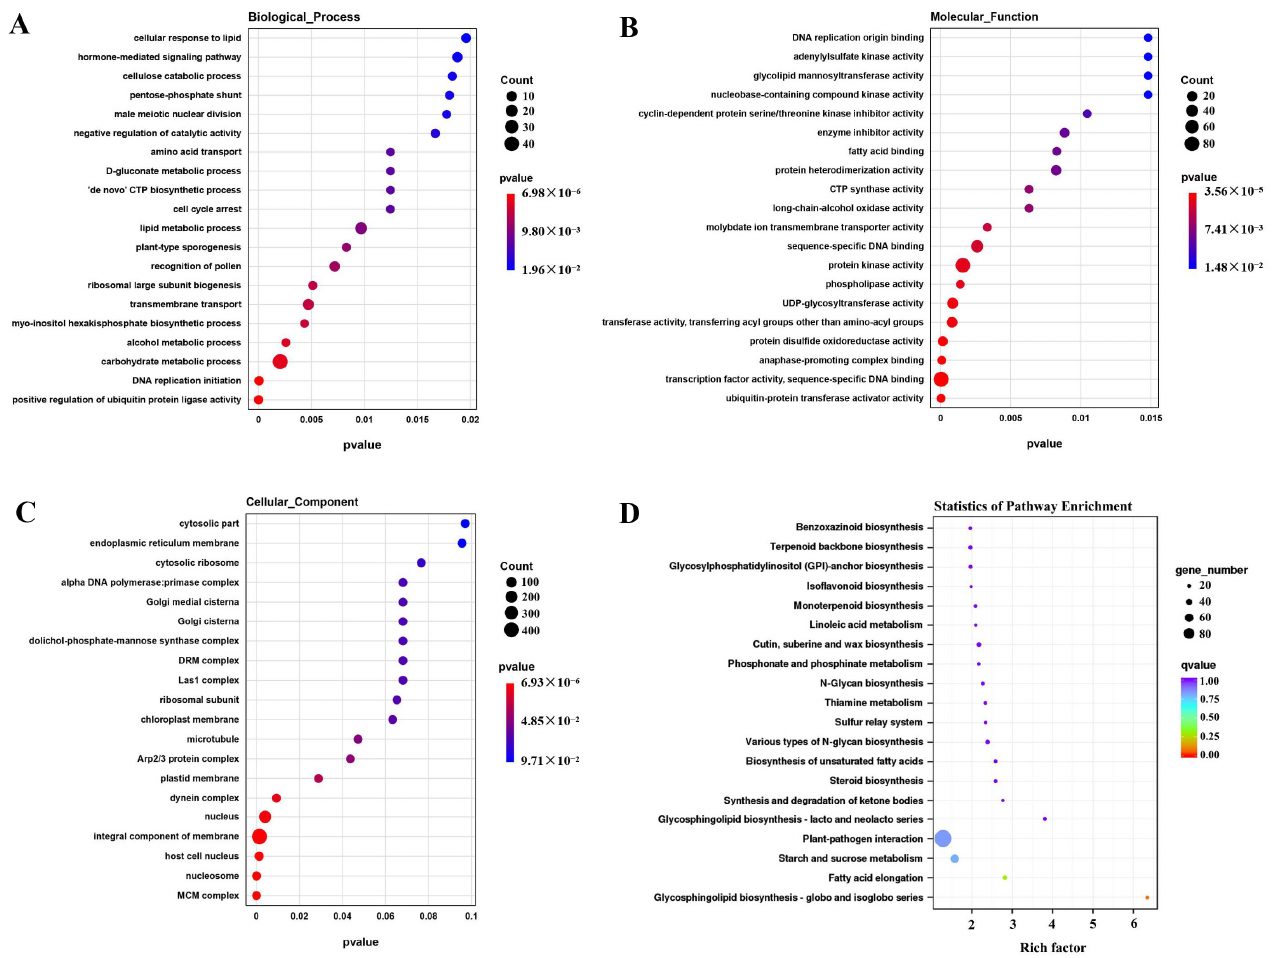
Figure 3. GO enrichment and KEGG pathway analysis of genes with different change patterns in two lines. ( A ) shows the top 20 enriched GO terms on Biological Process. ( B ) shows the top 20 enriched GO terms on Molecular Function. ( C ) shows the top 20 enriched GO terms on Cellular Component. The size of the circles represents the number of DEGs annotated in this pathway, and the color of the circles represents the p value. A lower p value indicates greater enrichment intensity. ( D ) Scatterplot of KEGG pathways shows the top 20 enriched pathway terms in genes with different change patterns in two lines. The sizes of the circles indicate the number of genes. The Rich factor is the ratio of the number of DEGs annotated in a given pathway to the number of all genes annotated in this pathway. The q value is the corrected p value and ranges from 0 to 1, with a lower q value indicating greater intensity.